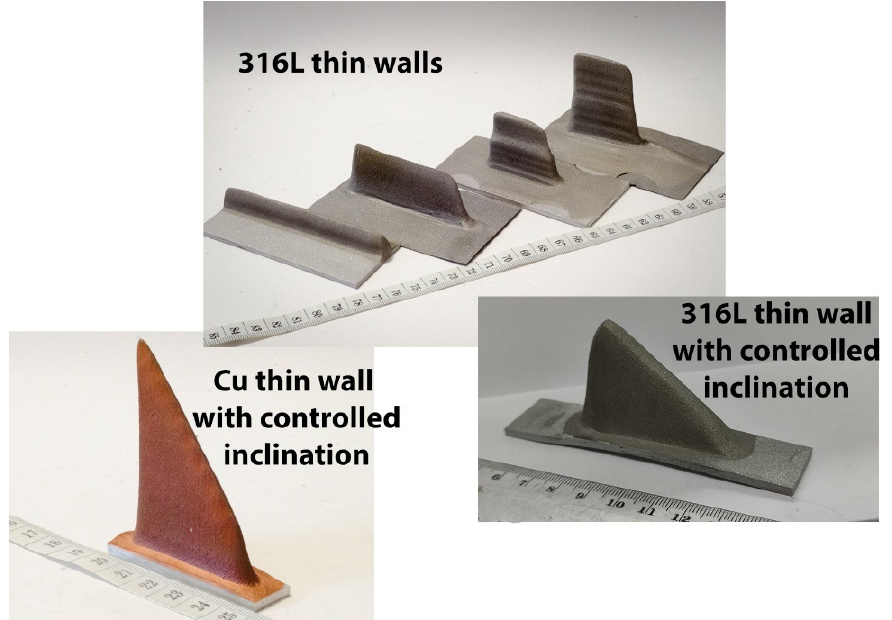
Figure 11. CSAM straight thin wall parts made by Metal Knitting strategy on flat substrate.